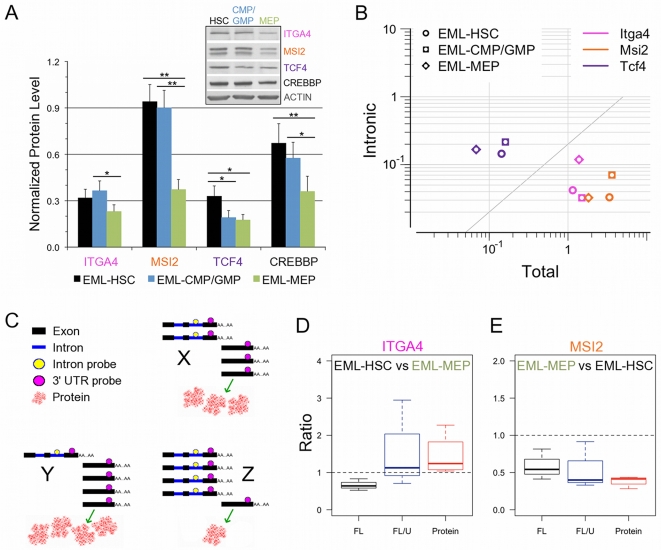
Regulated changes in protein levels and intronic sequence abundance as a function of differentiation stage.(A) Quantification of expression levels for the indicated proteins in phenotypically HSC-like cells (EML-HSC: Lin- SCA1+ CD34+ KIT++), early myeloid progenitors (EML-CMP/GMP: Lin- SCA1- CD34+ KIT++) and megakaryocyte/erythrocyte progenitors (EML-MEP: Lin- SCA1- CD34- KIT++). Bars indicate means + SEM of 4 independent experiments normalized to beta-actin levels. Significant differences in protein levels between cell types indicated by * for ANOVA p-values <0.05 and ** for <0.01. Inset: representative Western blots. (B) Full-length vs intronic qRT signals for the indicated genes in the EML subpopulations described in A. Shown are median values from 3 independent experiments. (C) Model of the potential impact of varying intronic levels for a constant level of full-length mRNA. Exonic sequences are represented by black rectangles and introns by blue lines. Probes for intronic and full-length sequences are indicated by yellow and magenta circles, respectively. For each of X, Y and Z, the full-length level is the same (5 magenta circles) but the proportion of unspliced transcript varies (X = 2 probes, Y = 1 and Z = 4). The corresponding protein levels (pink blobs) reflect the relative proportion of spliced and unspliced transcript since only the latter can be translated. (D) Ratio of full-length mRNA (black box, F), full-length/unspliced (blue box, F/U) and protein (red box, P) in EML-HSC relative to EML-MEP for Itga4 (E) As in (D) but for Msi2 in EML-MEP vs EML-HSC. Whisker plots in (D) and (E) show median (line inside box), interquartile range (limits of the box) and data range (limits of whiskers).